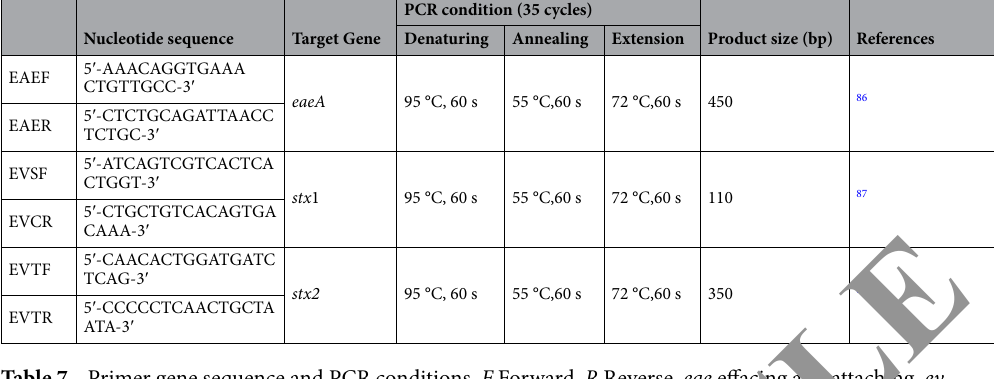
Table 7. Primer gene sequence and PCR conditions. F Forward, R Reverse, eae effacing and attaching, ev Verocytotoxin, stx shiga toxin, bp base pair.